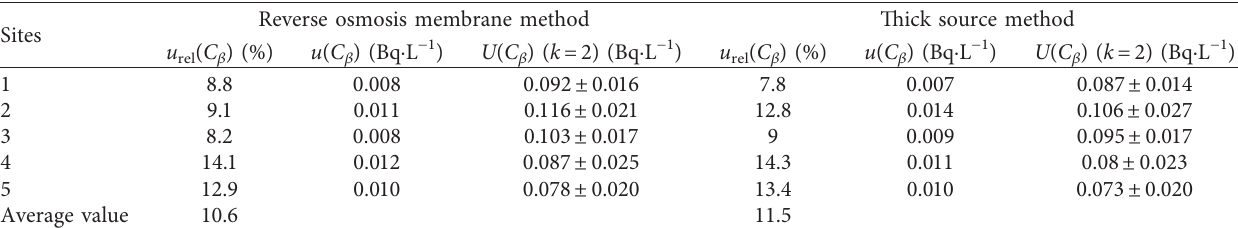
Table 3: Measurement uncertainty of total β in each region.